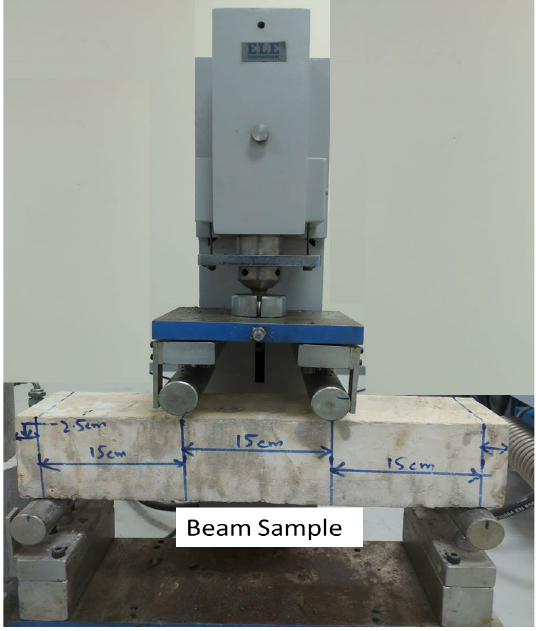
Figure 3. Setup for flexural testing of beam specimen.